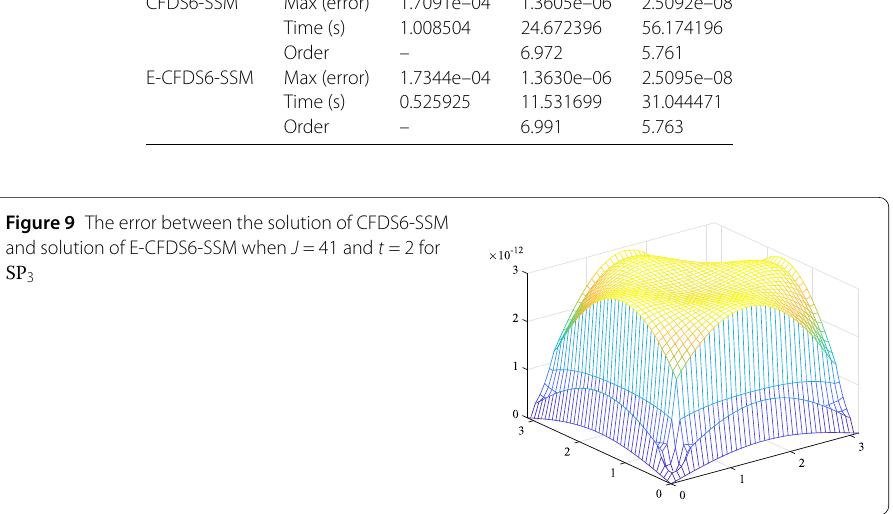
Table 6 The convergence order and computational time for SP 3 at t = 2 Nodes 11 × 11